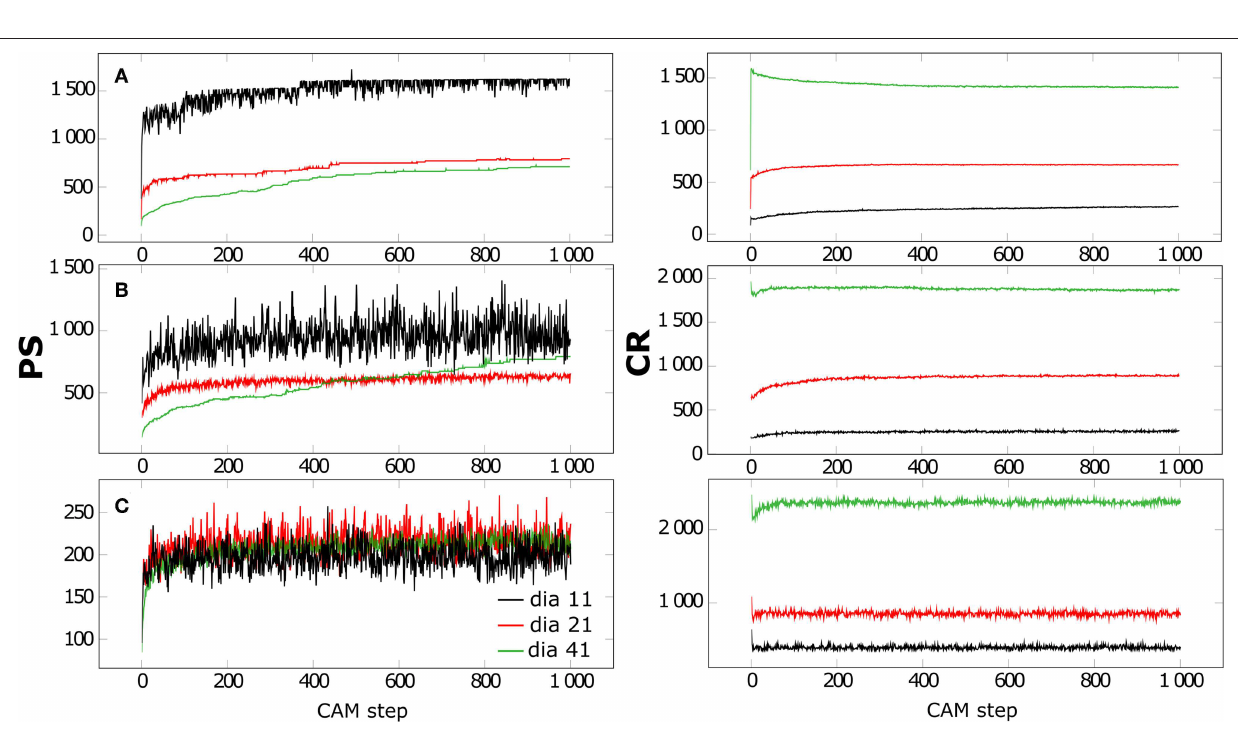
FIGURE 3 | Average particle sizes (PS) and compactness ratios (CR) for CBUs plotted as function of time. The initial conditions were set to an area fraction of 20% and a composition of 6% Gt, 6% Il pos and 88% Qz (A) , 12% Gt, 12% Il pos and 76% Qz (B) as well as 24% Gt, 24% Il pos and 52% Qz (C) of different sizes: small diameter of 11 (green), medium diameter of 21 (red) and large diameter of 41